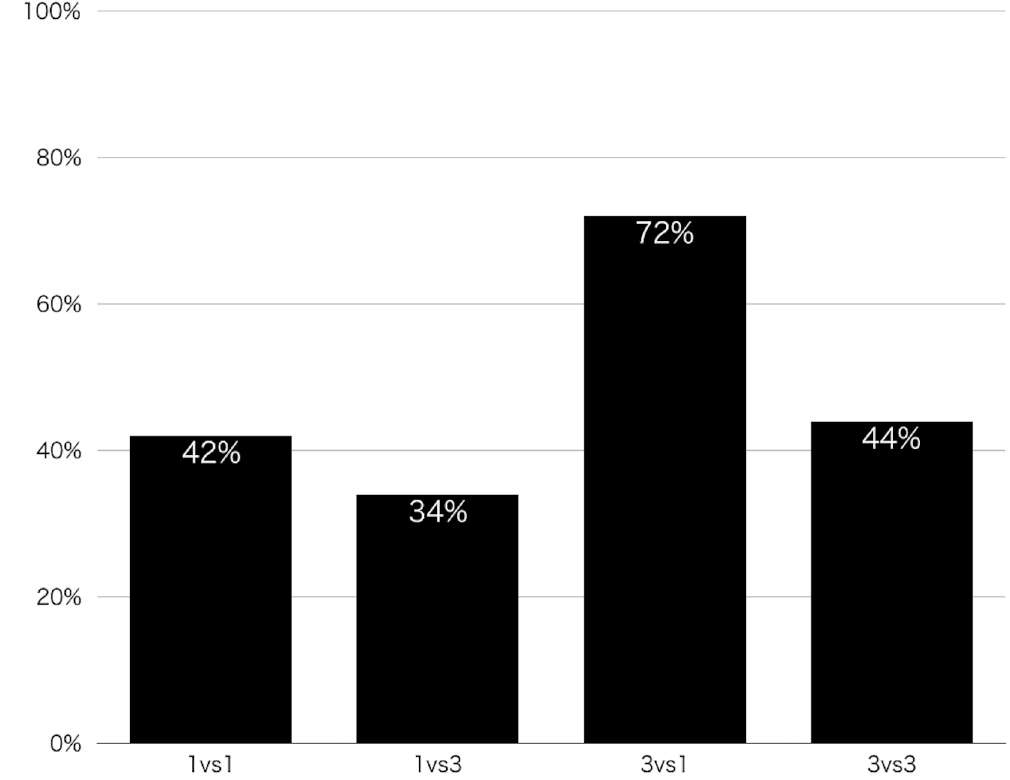
Fig 1. Attack rate in the four